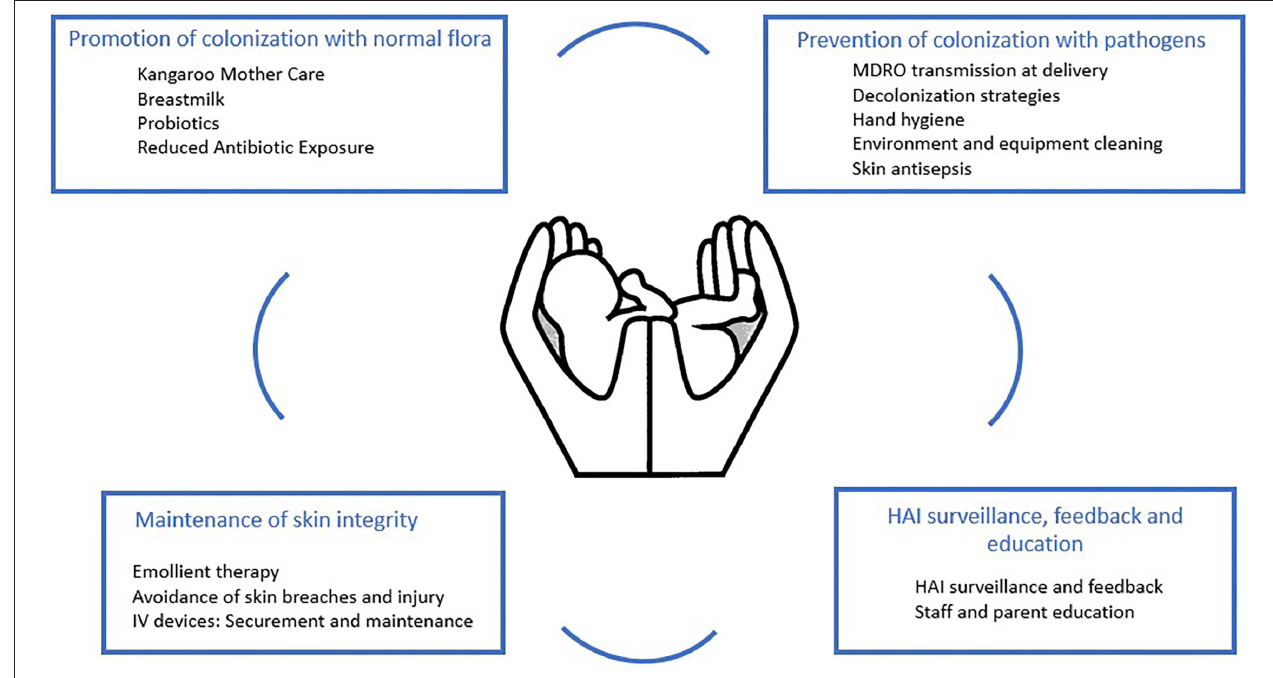
FIGURE 1 | Key interventions for the prevention of healthcare-associated infections in